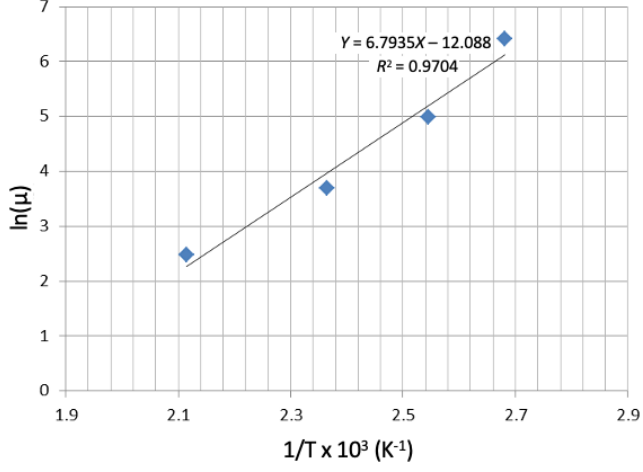
Figure 4. Arrhenius-type plots of ln ( µ ) versus 1/T and regression fit to calculate shear activation energy (at a shear rate of 8.4 s −1 ) for the QI-removed coal tar pitch.